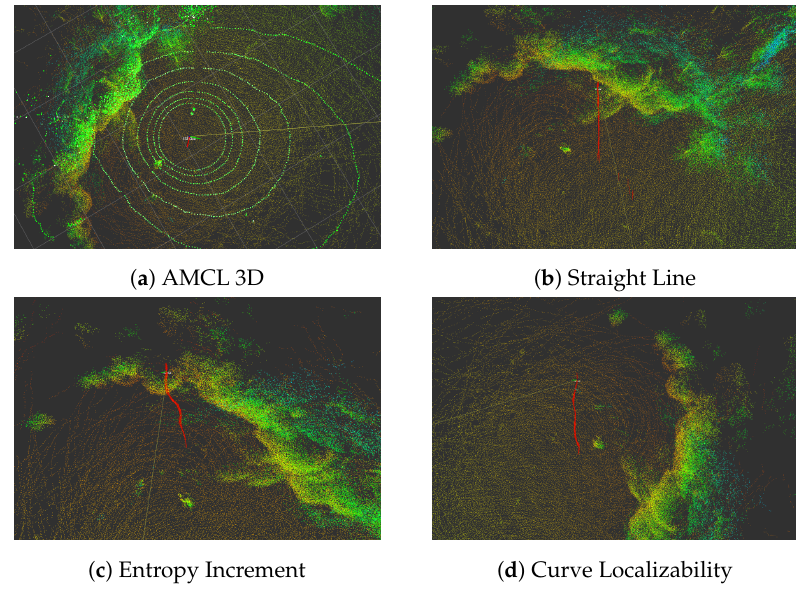
Figure 11. Trajectories of active localization algorithms.